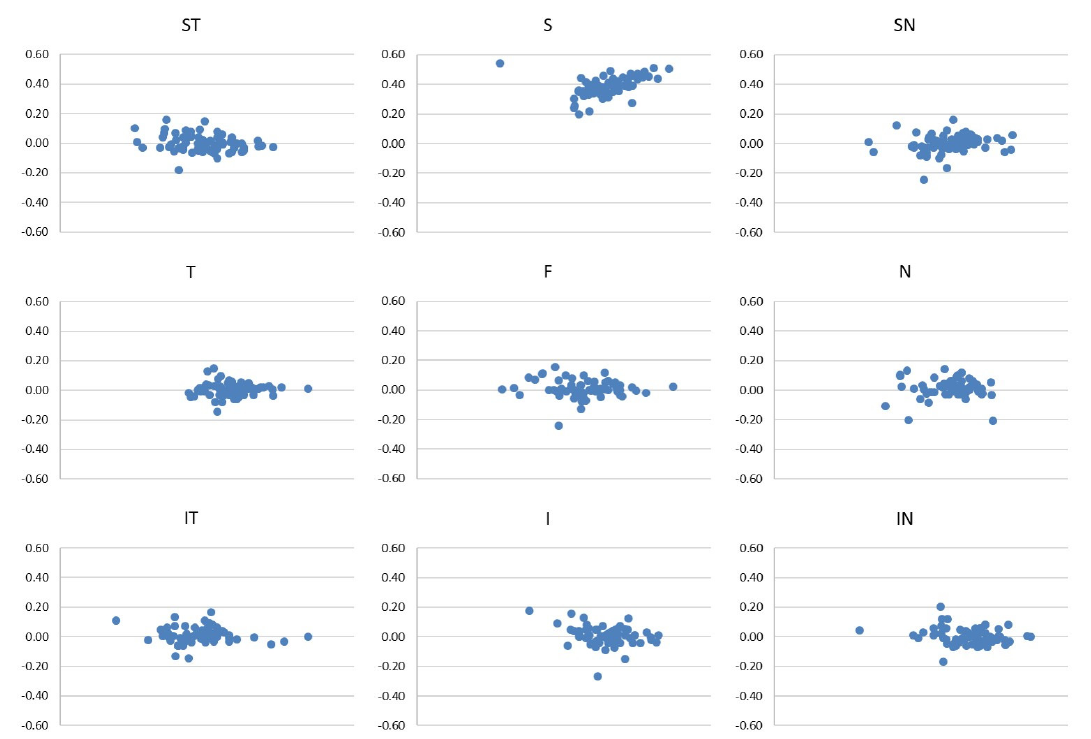
Figure 3. Bland–Altman plots of the first and the second scan of each sector of SCP.